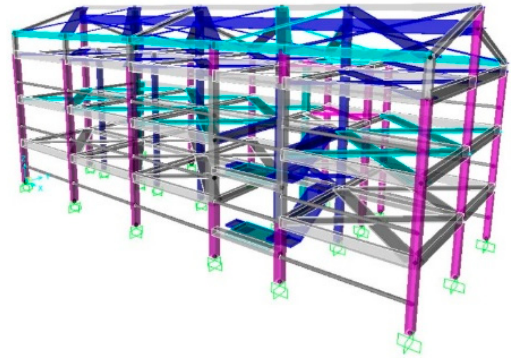
Figure 8. Finite element model of the